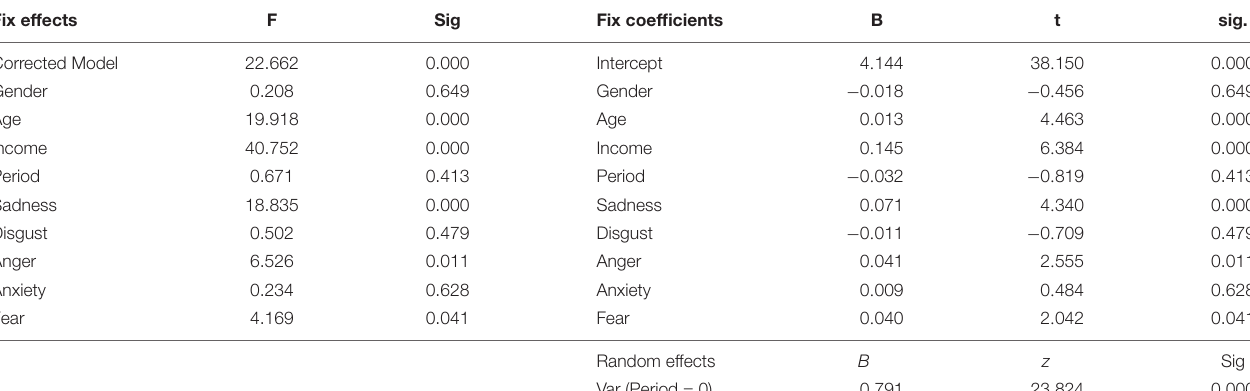
TABLE 2 | Effects of emotions on coping strategy of interdependent information